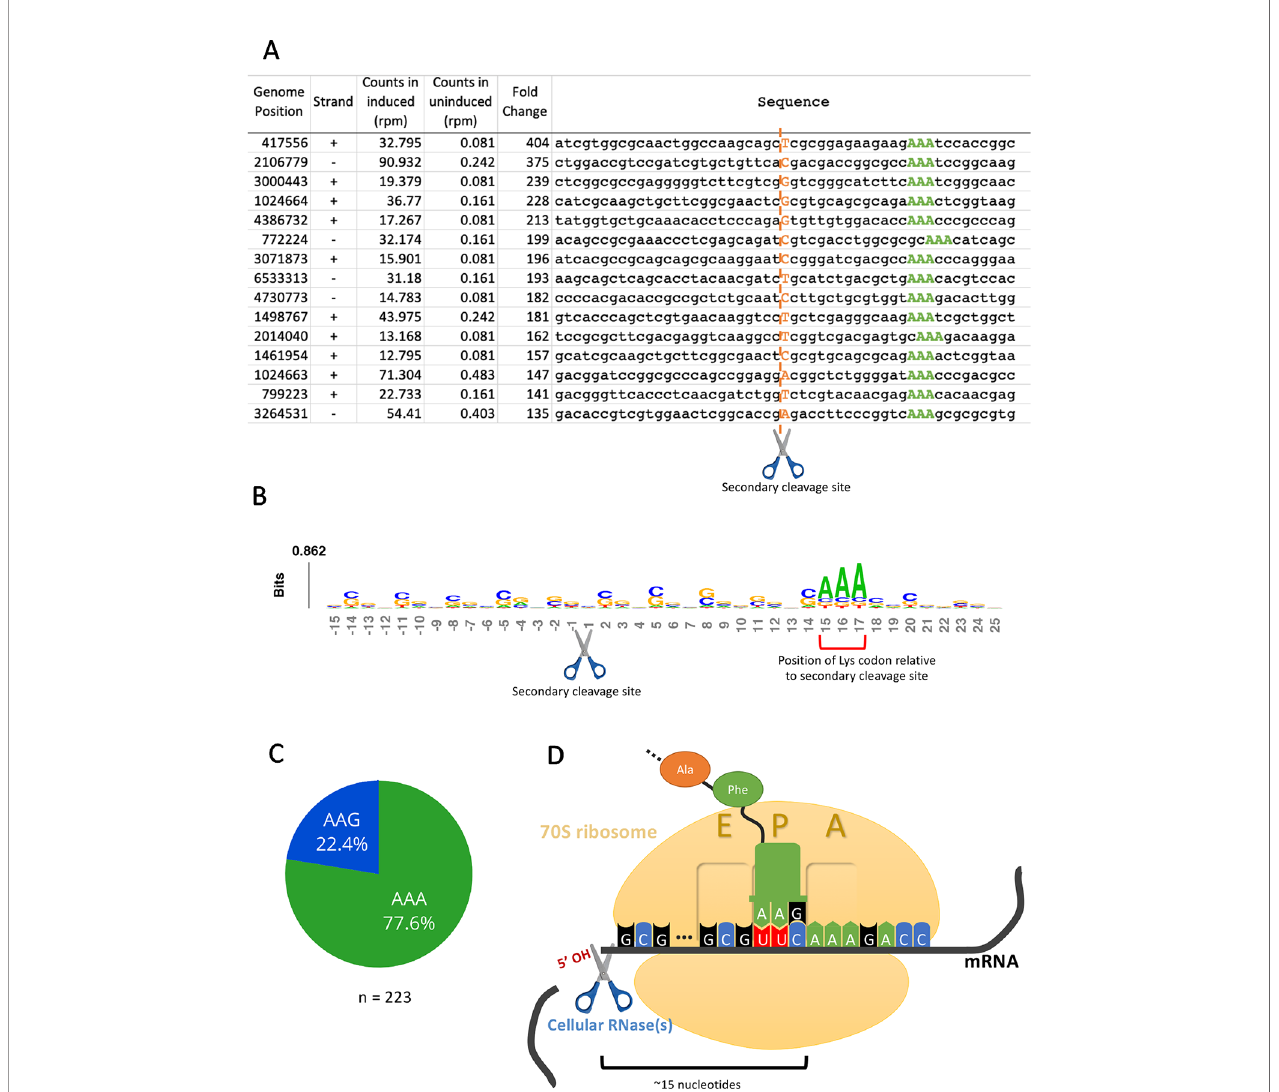
FIGURE 4 | 5 ’ RNA-seq serendipitously reveals ribosome stalling at lysine codons. (A) Top mRNA hits found in the 5 ’ RNA-seq dataset. The 50 nucleotides surrounding the secondary cleavage site (dotted line) generated by one or more cellular RNases (scissor) are shown. Lysine AAA codons are indicated in green, approximately 15 nucleotides downstream of the cleavage site. The fi rst nucleotide (adjacent to the 5 ’ OH) of the read is highlighted in orange. Counts are normalized to reads per million (rpm). (B) Sequence logo summarizing the 130 detected mRNA hits. The height of each nucleotide is proportional to its frequency at that given position. Positions are numbered relative to the secondary RNase cut site (scissor). Red bracket indicates the position of lysine AAA codons. (C) Proportion of stalling in AAA codons vs. AAG codons found by 5 ’ RNA-seq in 223 annotated transcripts with at least 1 rpm in the induced sample and containing a lysine codon at or near +15. (D) Schematic representation demonstrating the events following the depletion of the cellular levels of tRNA Lys by MazF-ms. Due to the lack of available tRNA Lys , translating ribosomes stall mainly at lysine AAA codons at the A site. Ribosome stalling events likely trigger mRNA cleavage at 5 ’ side of the stalled ribosome by one or more cellular RNases